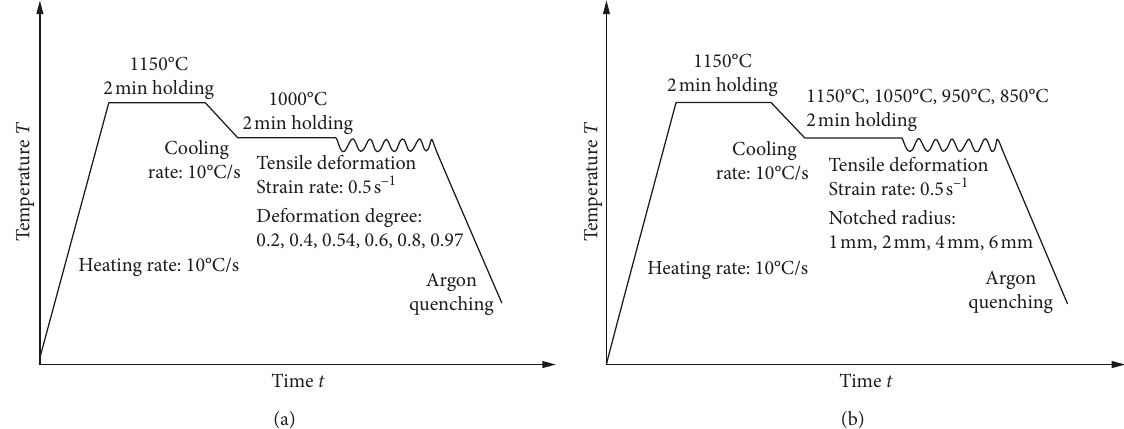
Figure 3: Experimental procedure used for hot tensile tests: (a) uniaxial high-temperature tensile; (b) notch high-temperature tensile.